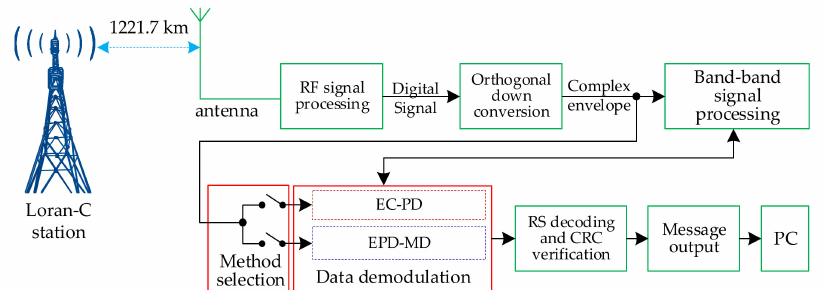
Figure 10. Test platform of data demodulation